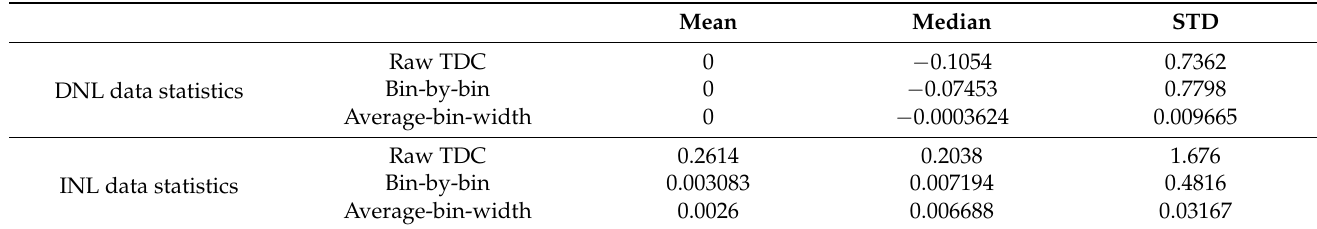
Figure 13. DNL and INL values for a synchronous TDC, before and after applying the two calibration methods: ( a ) DNL values; ( b ) INL values. Table 1. DNL and INL statistics for a synchronous TDC calculated for the non-calibrated histogram and the calibrated histograms of the two